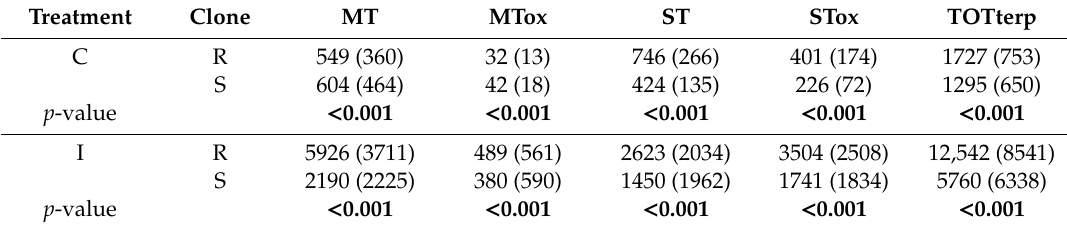
(Table 1) and bark tissues (more than twice the concentration of the S one, that was 12,542 vs. 5760 µ g / g) (Table 2). With regard to the intact plants C, the higher ( p < 0.001) concentration of MT (3134 vs. 2894 µ g / g) and MTox (239 vs. 158 µ g / g) in the leaves was found in the S clone (Table 1), while the ST and STox were higher ( p < 0.001) in the R clone (2231 vs. 1529 µ g / g and 1204 vs. 1100 µ g / g, respectively). After infection, the significant di ff erences between the clones were maintained even when the dead leaf samples were removed: TOTterp, MT and MTox were slightly higher in the clone S (live) compared to S (live and dead) while the STs were even lower. After the fungal infection, the concentration of all terpenoid categories in the bark tissues were markedly higher ( p < 0.001) in the R clone compared to the S clone (Table 2). The e ff ect of the FMC on the concentration of terpenoids in the leaves